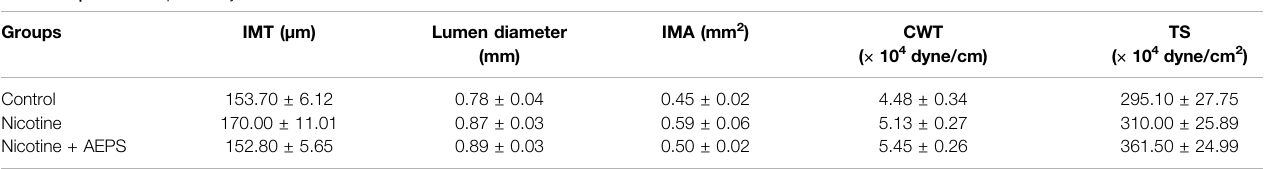
TABLE 2 | Aortic morphometry